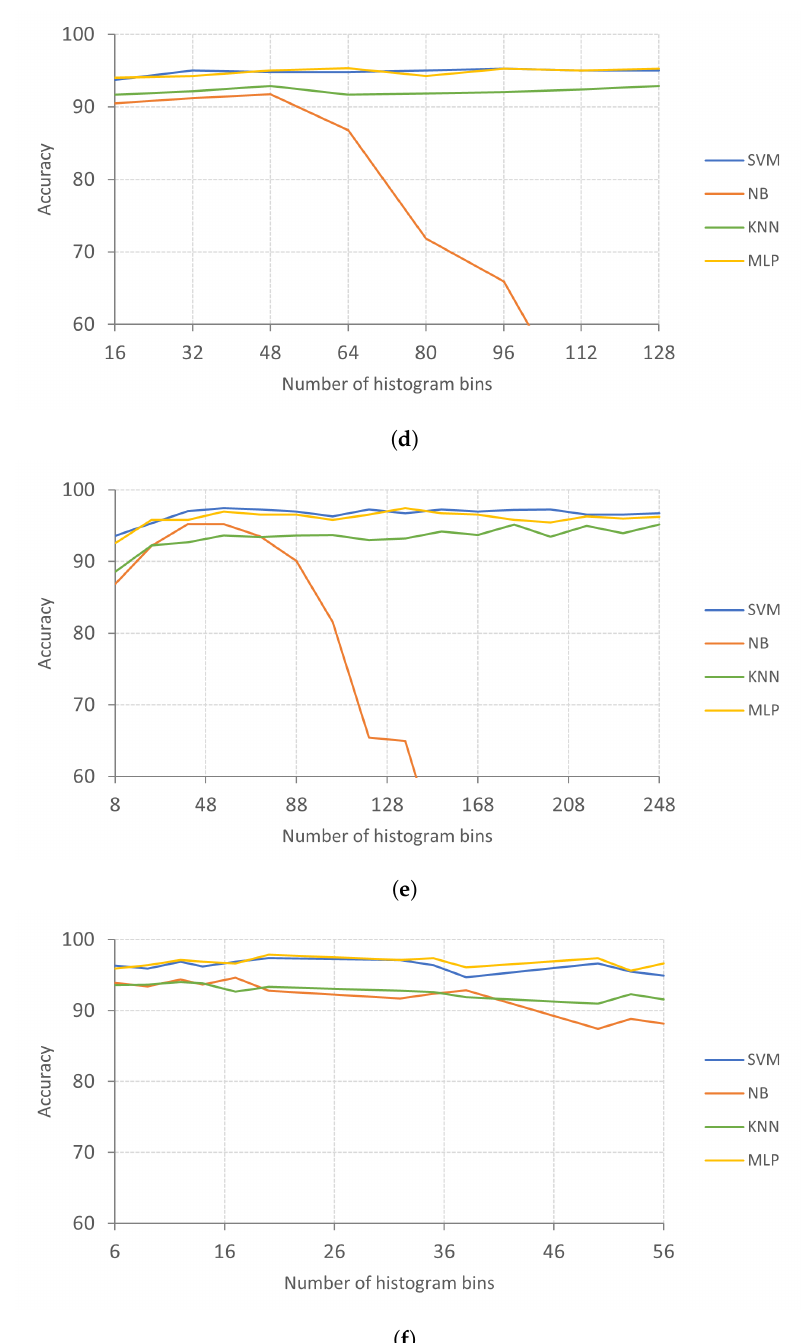
Figure 4. FER results for different numbers of bins on the RFD dataset with 6 expressions ( a ) WLD results; ( b ) LDP results; ( c ) ALDP results; ( d ) LBP results; ( e ) CLBP results; ( f ) HOG